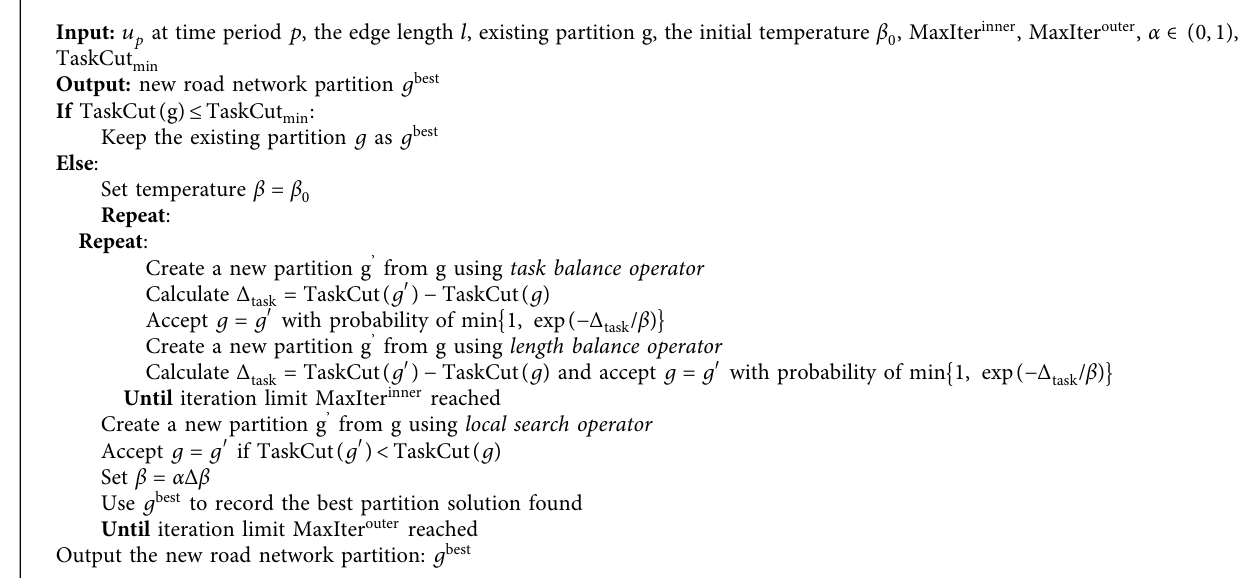
A LGORITHM 1: Simulated annealing-based partition adjustment